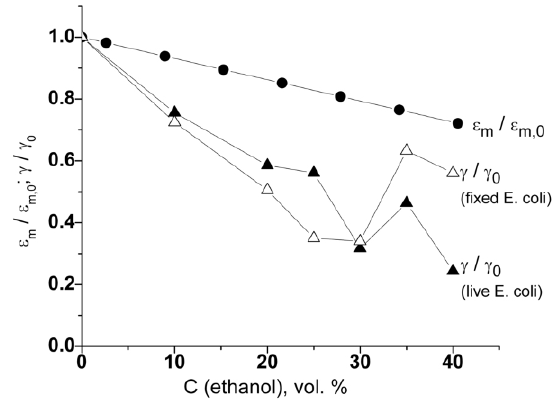
Figure 7. The relative electric polarizability ( g / g